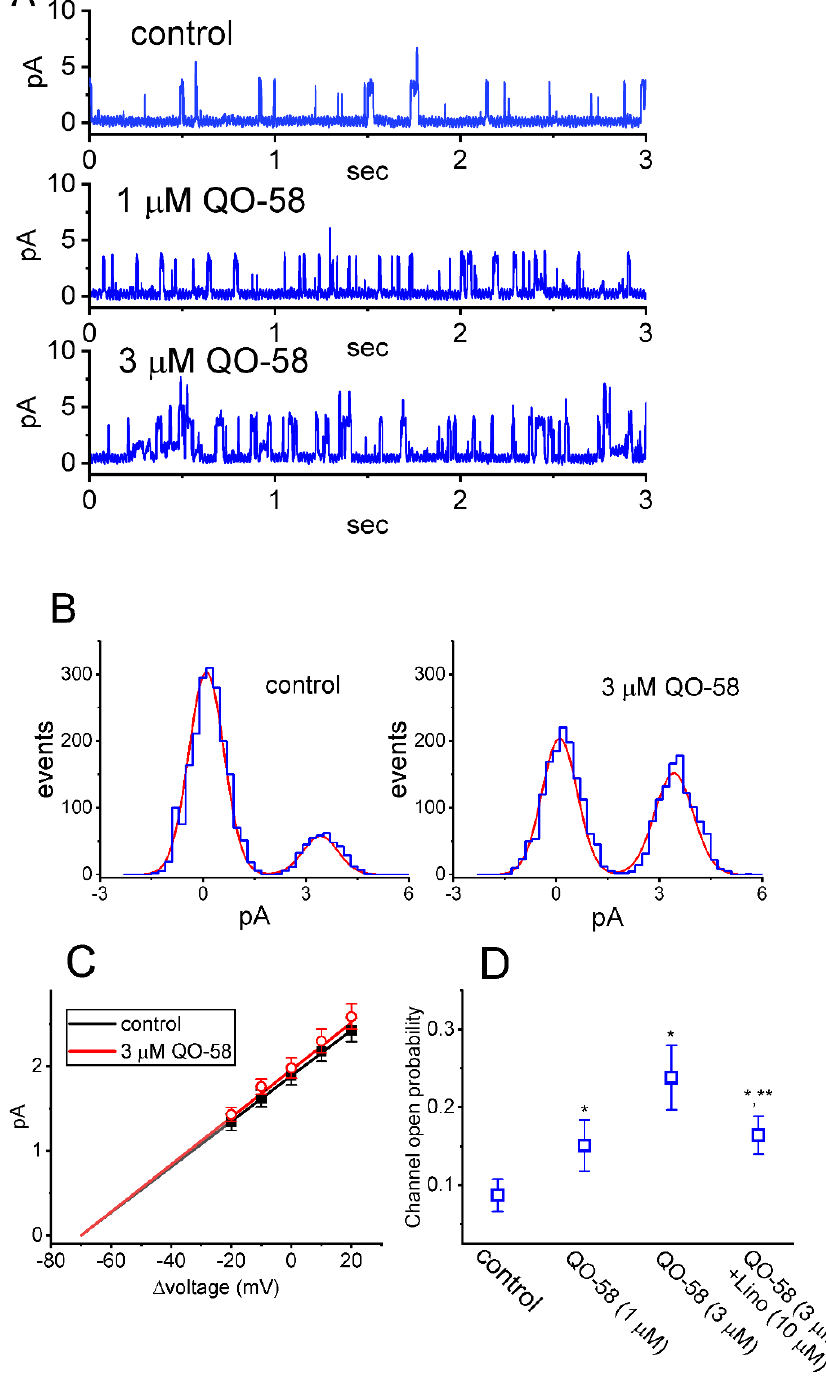
Figure 4. Stimulatory effect of QO-58 on the activity of M-type K + (K M ) channels recorded from GH 3 cells. In this series of cell-attached current recordings, cells were bathed in high-K + , Ca 2+ -free solution, and we filled up the recording pipette with low-K + (5.4 mM) solution. ( A ) Representative single K M channels in the control period (upper) and during cell exposure to 1 μM QO-58 (middle) or 3 μM QO-58 (lower). The channel activity in the absence or presence of QO-58 was taken at the level of +20 mV relative to the bath. The upward deflection indicates the opening event of the channel. ( B ) Amplitude histogram taken in the absence (left) and presence (right) of 3 mM QO-58. ( C ) Average I-V relationship of single K M channels in the absence (solid black squares) and presence (open red circles) of 3 μM QO-58 (mean ± SEM; n = 8 for each point). Of note, the linear relationship of K M channels versus ∆ voltage was superimposable between the absence and presence of QO-58; hence, the single-channel conductance of the channel between the absence and presence of 3 μM QO-58 did not differ. ( D ) Summary scatter graph showing effect of QO-58 (1 and 3 μM) and QO-58 (3 μM) plus linopirdine (Lino, 10 μM) on the probability of K M channels that would be open (mean ± SEM; n = 8 for each point). Channel activity was measured at +20 mV relative to the bath. * Significantly different from control ( p < 0.05) and ** significantly different from QO-58 (3 μM) alone group ( p < 0.05). 2.5. Effect of QO-58 on the Single-Channel Conductance and Activation Curve of K M Channels We further examined if K M -channel activity measured at different levels of mem- brane potentials could be altered by the presence of QO-58. As demonstrated in Figure 4C, the single channel conductance of K M channels achieved with or without application of QO-58 did not significantly differ (27 ± 3 pS [in control] versus 28 ± 3 pS [in the presence of 3 μM QO-58]; n = 8, p > 0.05), despite the increased probability of K M -channel openings in its presence. A summary showing effects of QO-58 and QO-58 plus linopirdine on K M - channel activity in GH 3 cells is also presented in Figure 4D. The results led us to reflect that as GH 3 cells were continually exposed to QO-58 (3 μM), the channel open probability was significantly attenuated by subsequent addition of linopirdine (10 μM). 2.6. QO-58-Mediated Stimulation of Ca 2+ -Activated K + Currents (I K(Ca) ) by the Presence of QO-58 Several small molecules (e.g., BMS-204352, naringenin, and QO-40) that demon- strated to stimulate K M -channel activity have been reportedly noted to regulate other types of K + currents (e.g., I K(Ca) ) [9,47,48]. For these reasons, we next explored if QO-58 is able to modify the amplitude of I K(Ca) residing in GH 3 cells. In these experiments we volt- age-clamped the tested cell at a holding potential of 0 mV to prevent the interference by other type of ionic currents (i.e., voltage-gated Ca 2+ currents) [56,57]. As demonstrated in Figure 5A, one minute after cell exposure to 3 μM QO-58, I K(Ca) amplitudes measured at different levels of membrane potentials increased. Average I-V relationships of I K(Ca) with or without the QO-58 (3 μM) presence are illustrated in Figure 5B. The concentration- dependent stimulation by QO-58 of macroscopic I K(Ca) amplitude was established and is